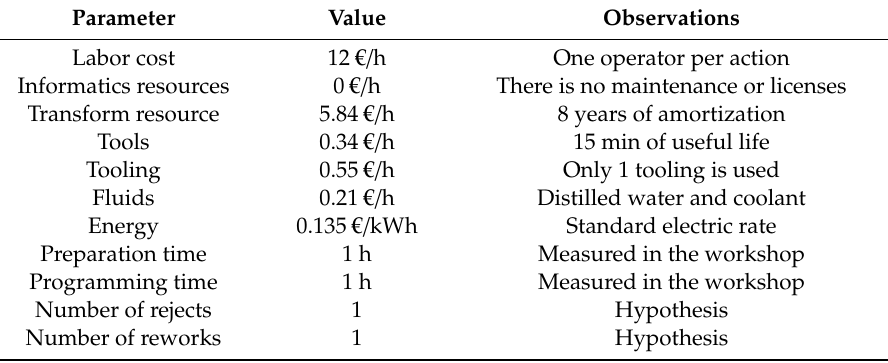
Table 1. Database